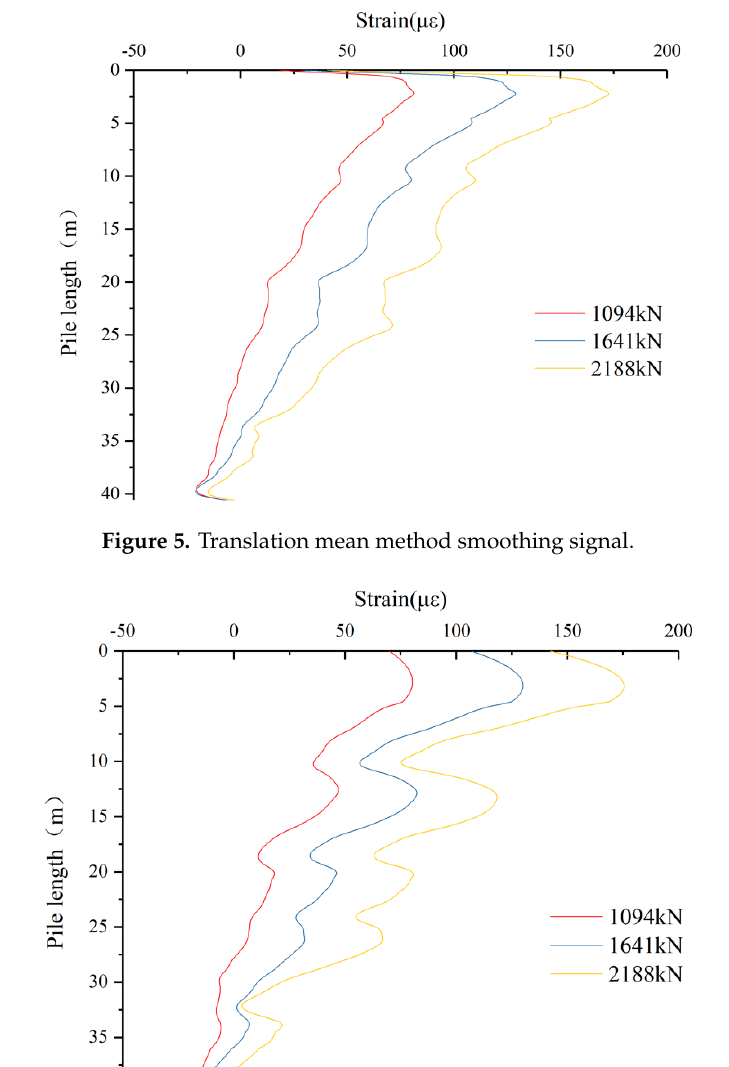
Figure 7. Percentile-filter smoothing signal.